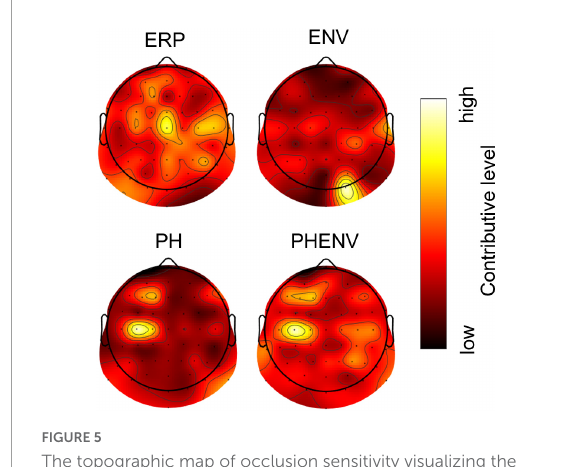
FIGURE5 The topographic map of occlusion sensitivity visualizing the important brain regions for classification. Dark to bright red color denotes relatively low to high contributive levels for